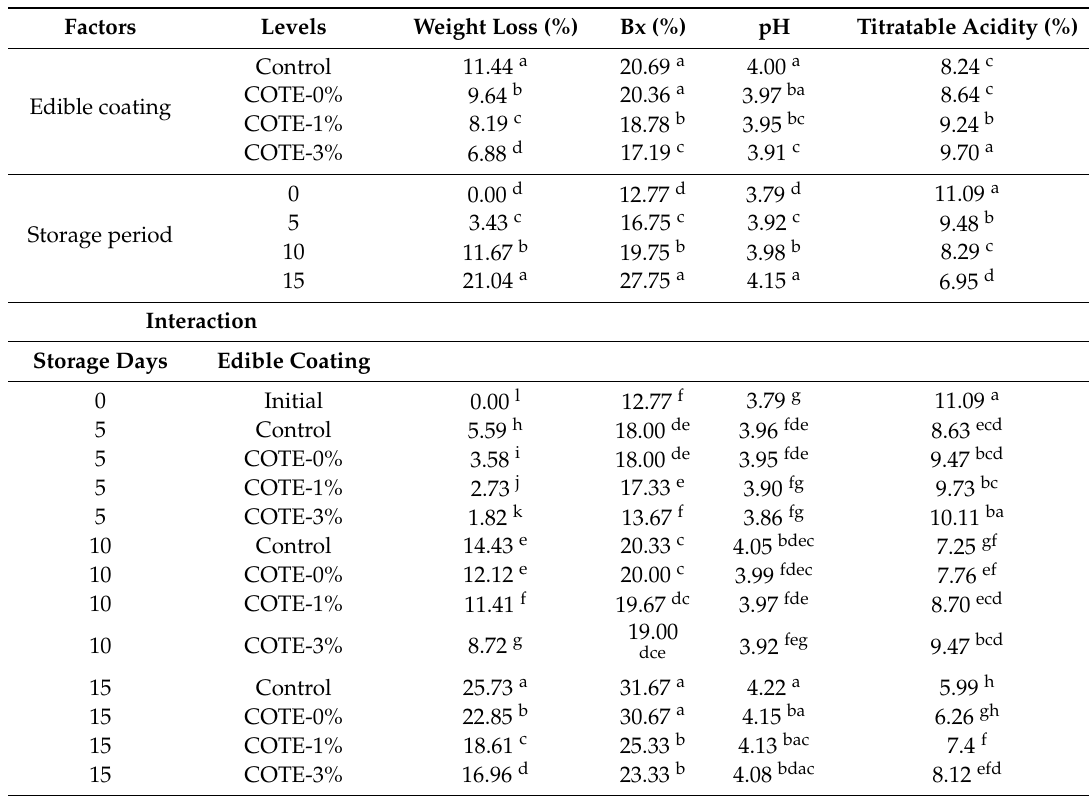
Table 1. Effect of edible coating incorporated with tomato oily extract and storage period on weight loss, Bx, pH, and titratable acidity of Myrtillocactus geometrizans fruits during